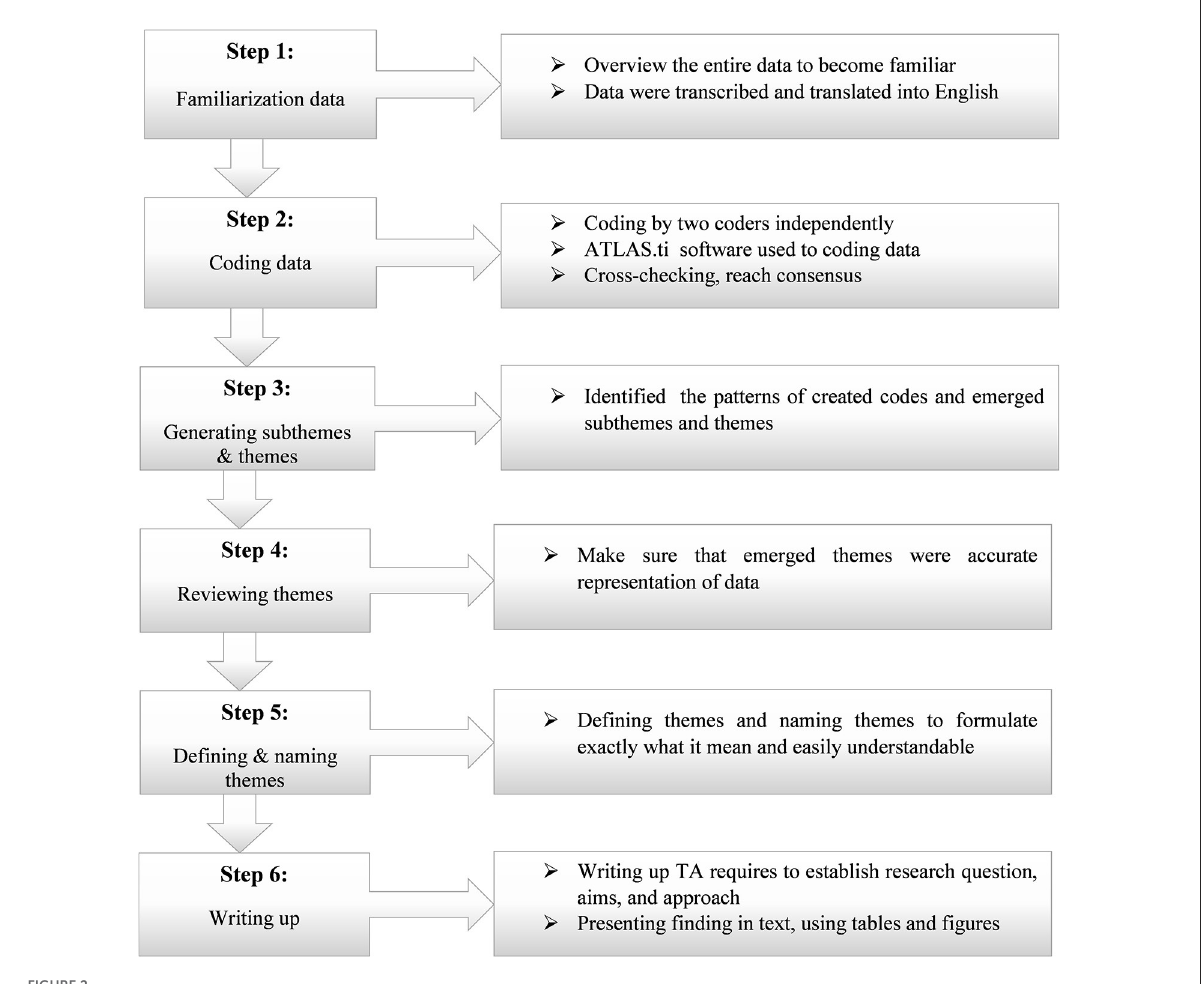
FIGURE2 Illustrates the steps of thematic data